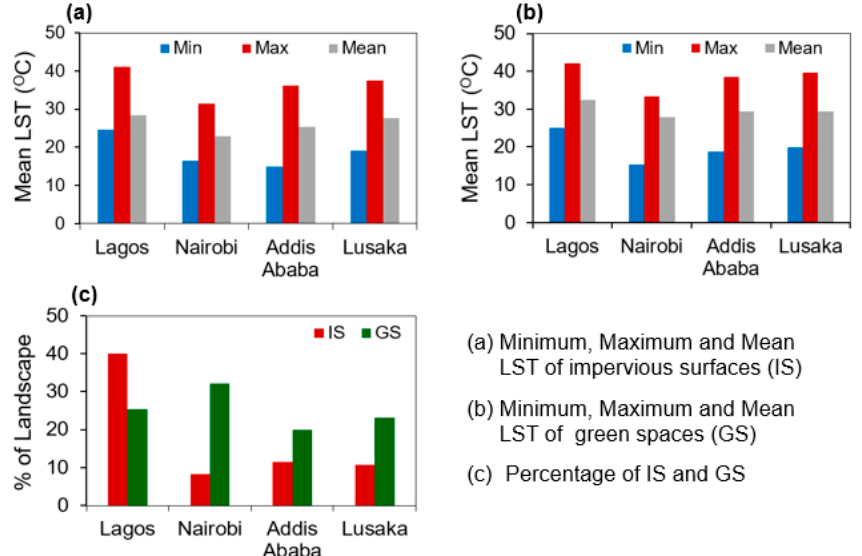
Figure 5. LST distribution and the percentage of impervious surfaces (IS) and green spaces (GS) in each study area.